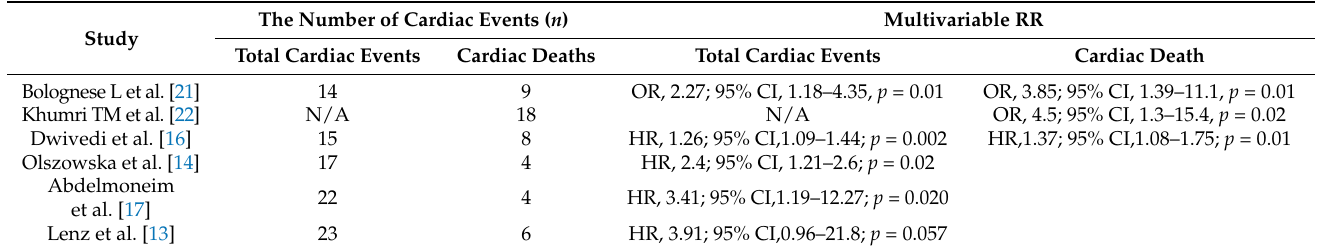
Table 2. The number of cardiac events and Outcome of multivariate analysis of risk for cardiac event.